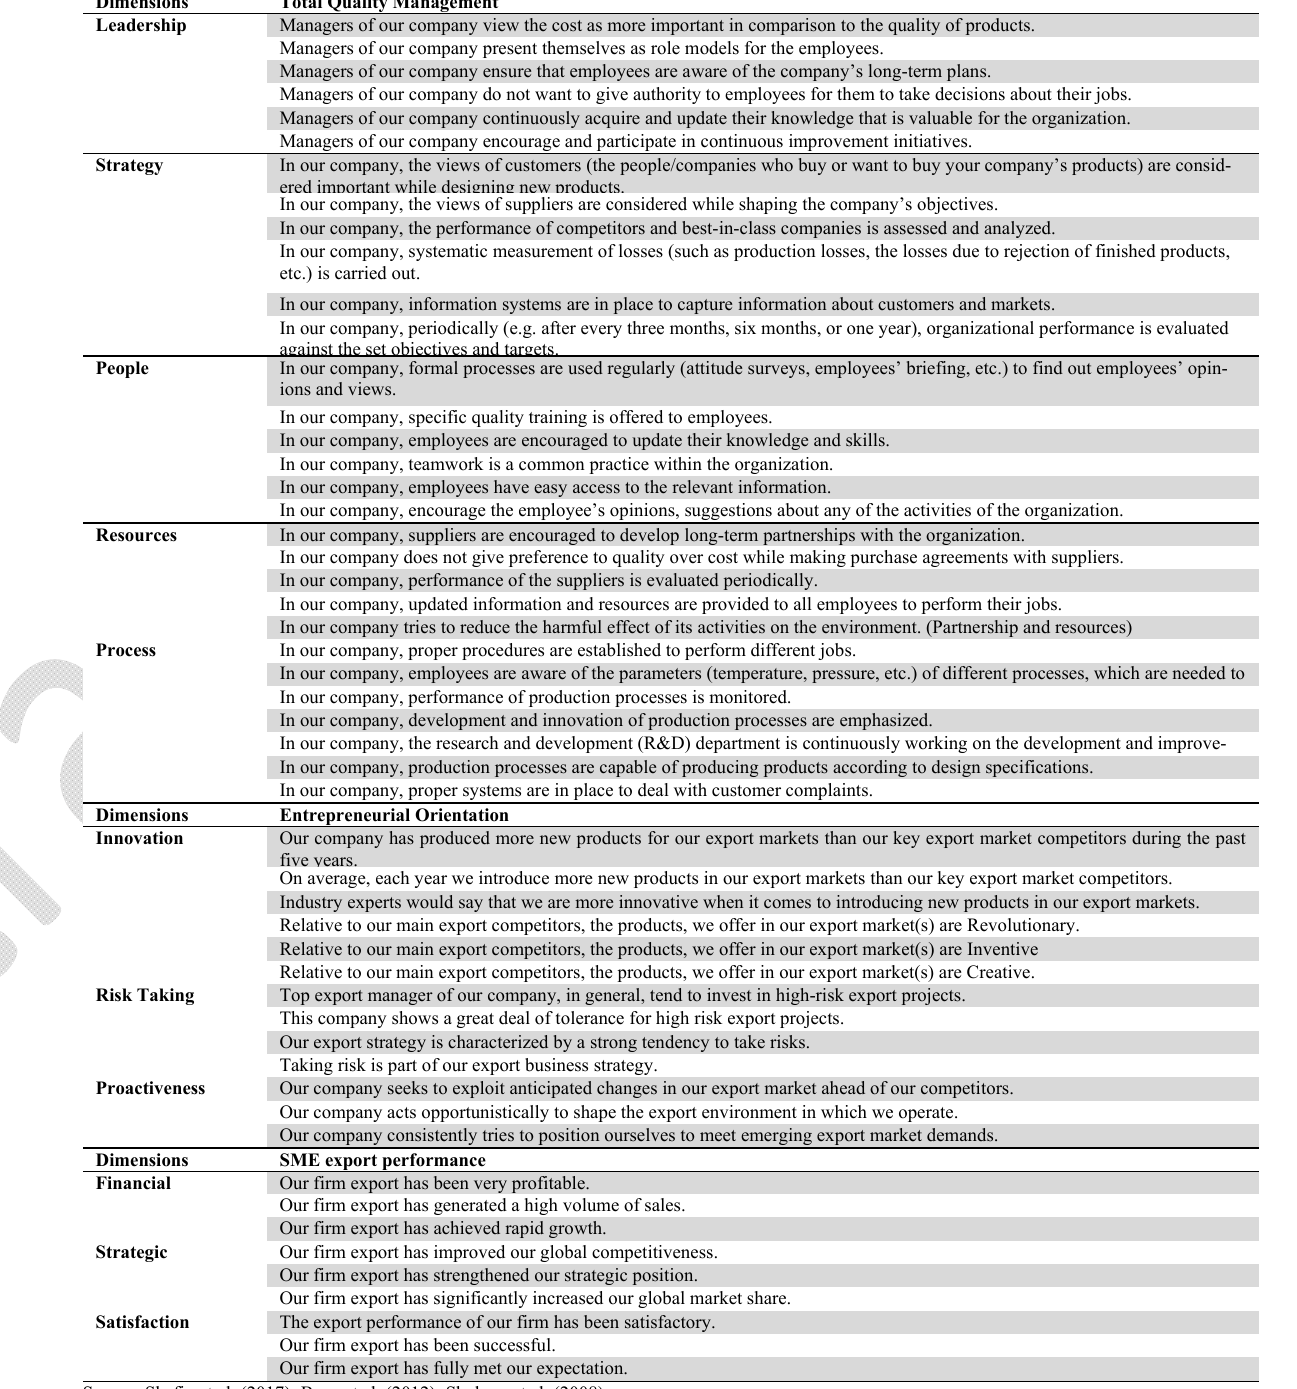
The scale of SME export performance and total quality management Dimensions Total Quality Management